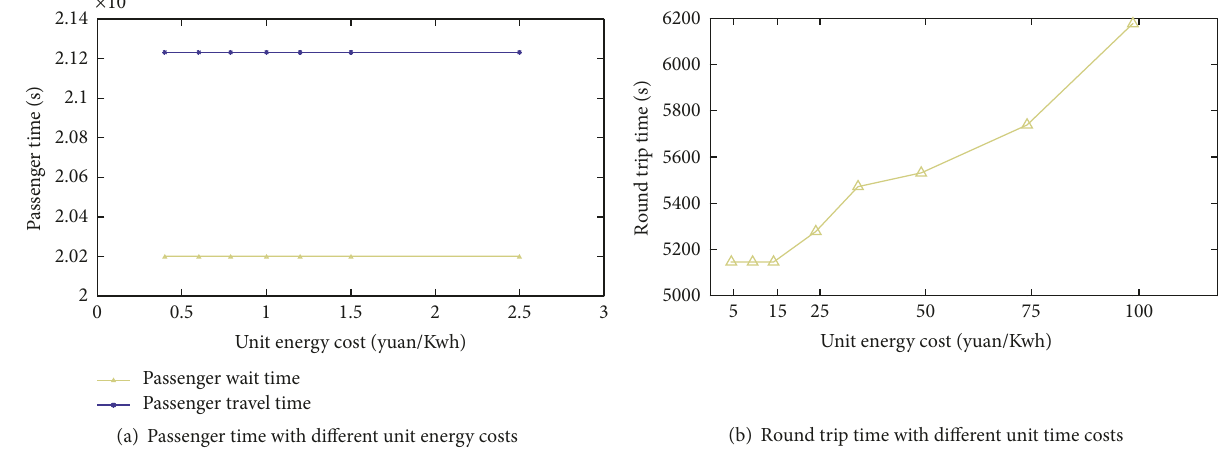
Figure 16: Sensitivity to unit energy